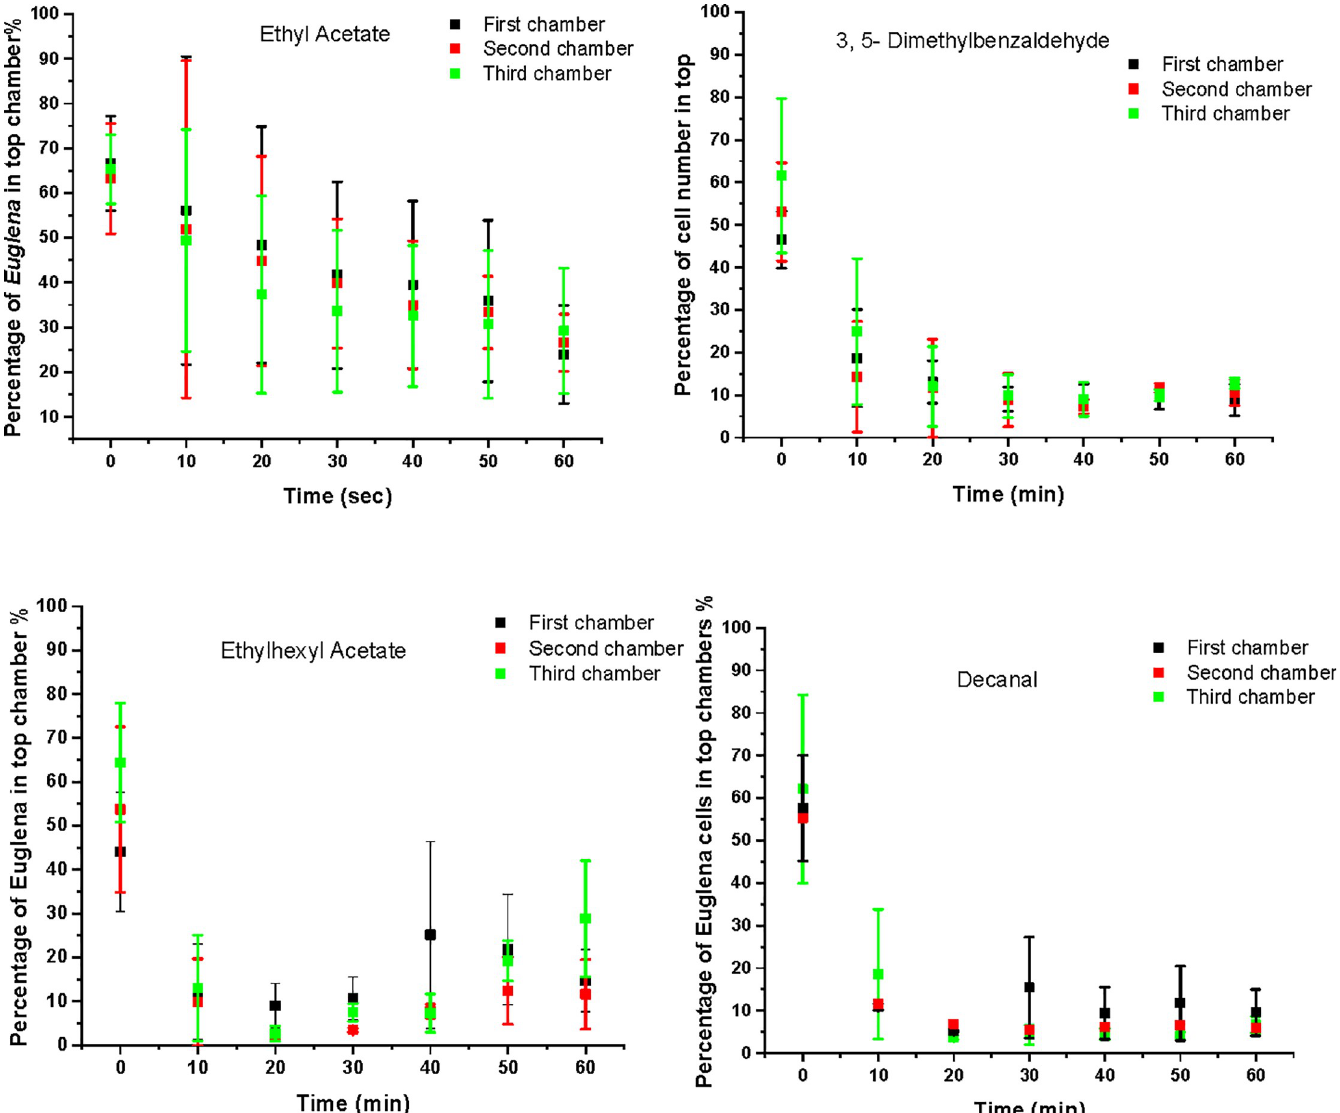
Fig 9. Population shift of Euglena cells inside the microfluidic system with different VOC molecules served as chemoattractant. Significant population shift can be observed when ethylhexyl acetate and decanal were used as chemoattractants.